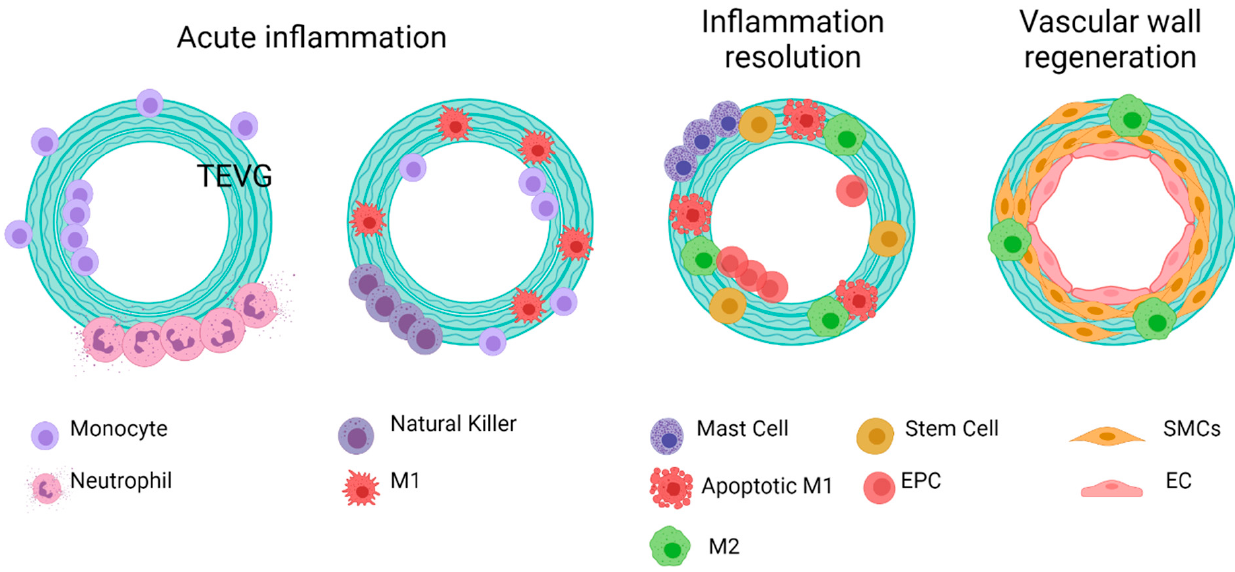
Figure 9. General idealized and summarized cell biomaterial interaction for the reendothelialization mechanism as a result of immune response activation over TEVGs. On the desired outcome, during the first stages after the implantation of regenerative vascular grafts, neutrophils and monocytes adhere to the inner and outer surfaces. The chemoattractant responses of these cells induce the infiltration of different kinds of cells, including hematopoietic stem cells. The acute inflammation stages induce the attachment of endothelial precursors. After one month, infiltrated cells on the vascular wall will differentiate towards functional smooth muscle cells and fibroblasts, and the adhered endothelial cells on the lumen will maturate. Therefore, a healthy endothelium will provide the required homeostasis for maintaining vascular graft patency (Created with BioRender.com, accessed on 7 November 2021).